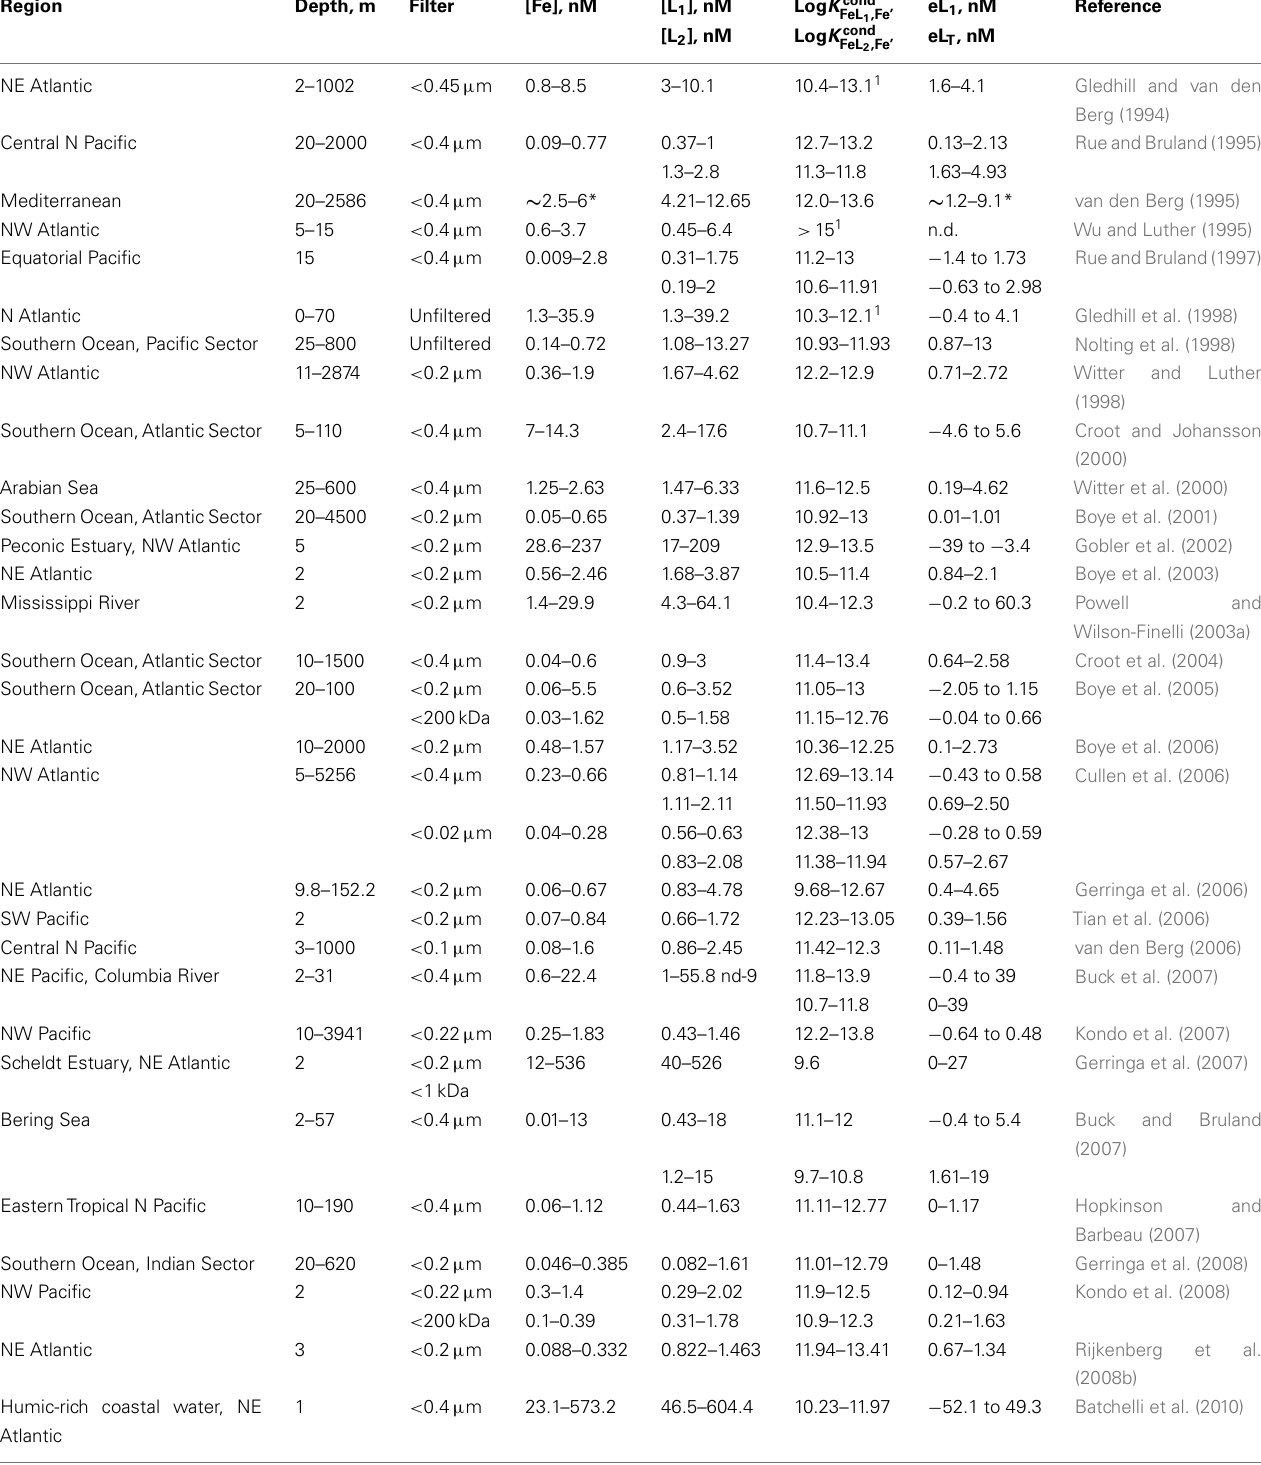
Table 1 | Compilation of published field data on the organic complexation of dFe in marine environments, as measured by CLE–ACSV